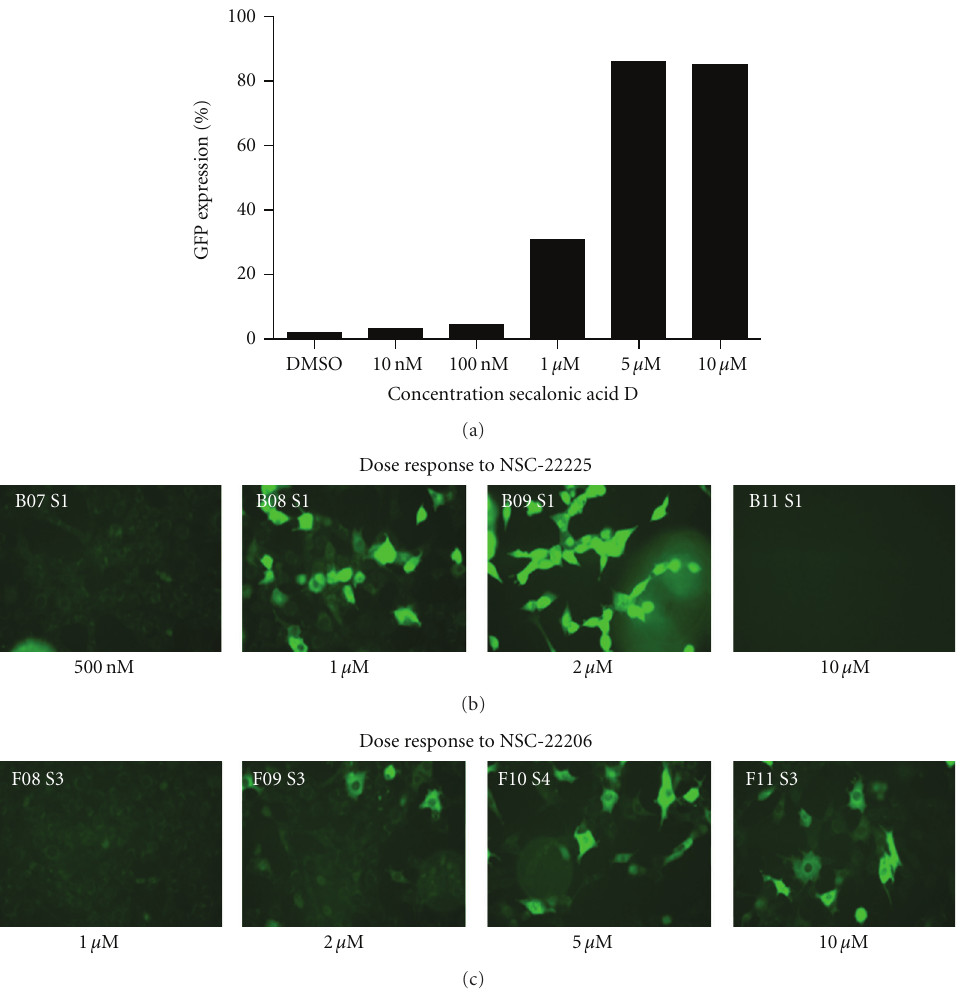
Figure 5: Characterization of assay hits. Dose-response experiments were performed with secalonic acid D, or NSC-159631 (a) and NSC- 22225 (b), a related molecule NSC-22206 (c), which di ff ers from NSC-22225 only by the metal salt (Cd for NSC-22225 and Hg for NSC- 22206). In all three cases, GFP expression was dose